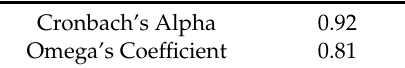
Table 3. Reliability